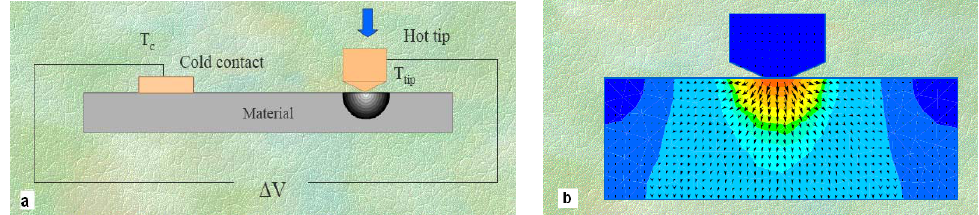
Figure 1. Schematic diagram of the ( a ) hot tip thermoelectric method and the ( b ) thermal gradient inside the sample.